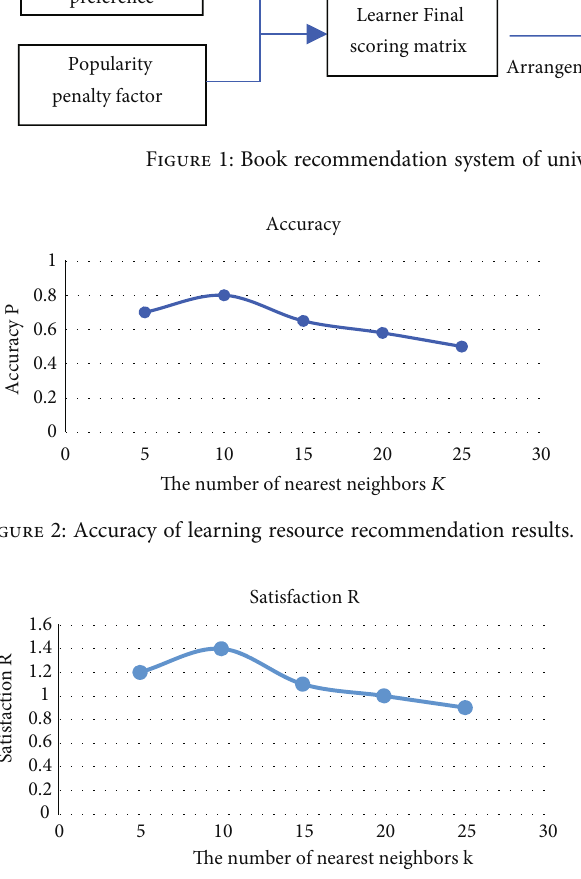
Figure 3: Satisfaction value of learning resource recommendation